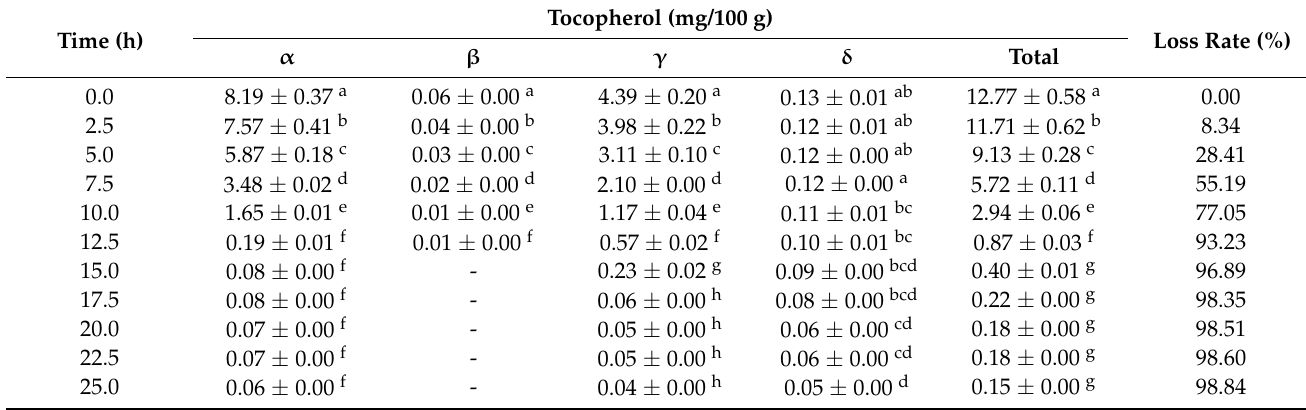
Table 3. Change in content of tocopherols during